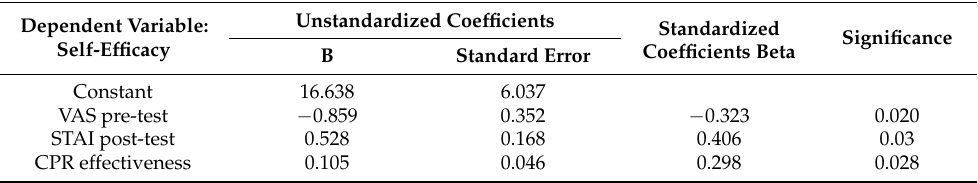
Table 4. Multiple linear regression analysis to model the relationship between self-efficacy scores and stress (VAS pre-test) and anxiety levels (STAI post-test) and CPR effectiveness. Dependent Variable: